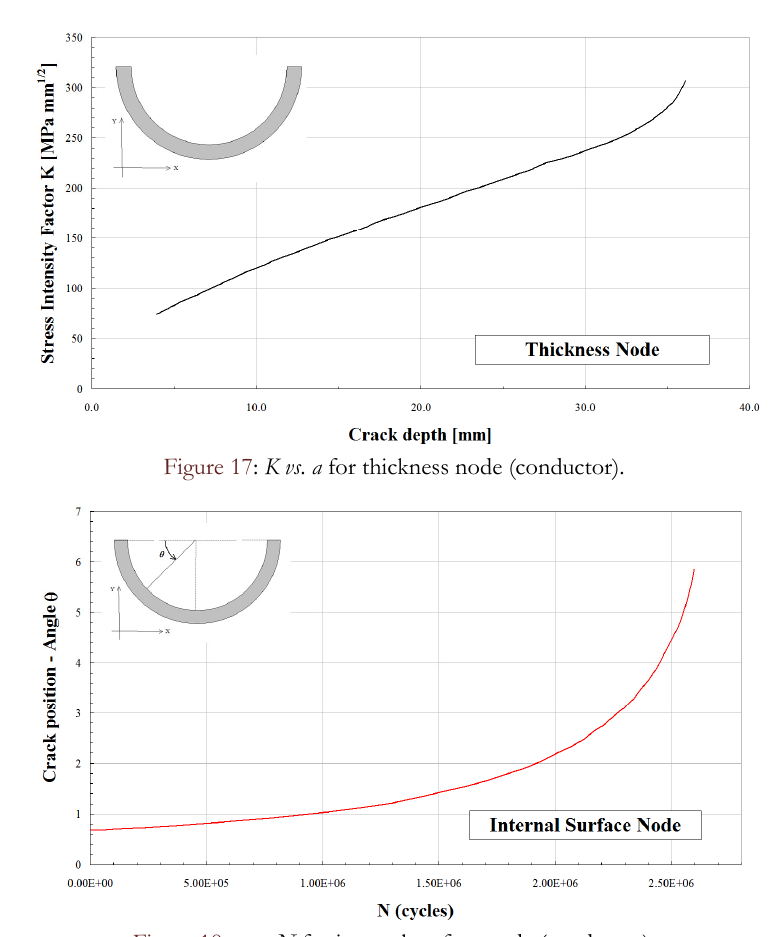
Figure 18: a vs . N for internal surface node (conductor).